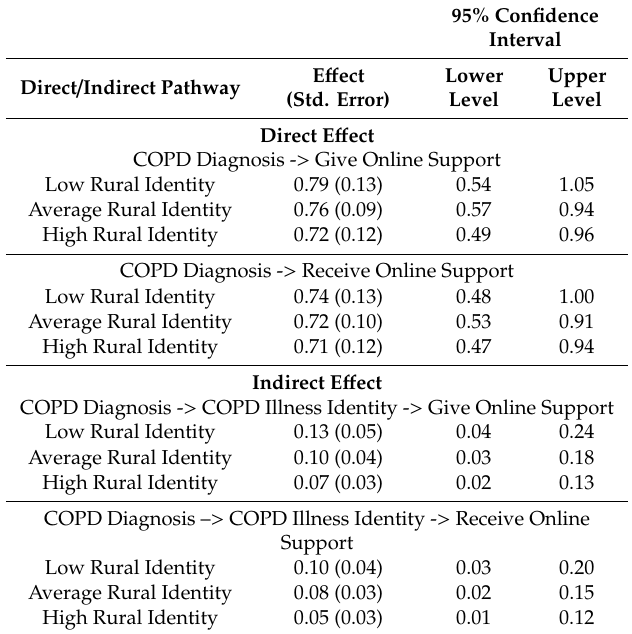
Table 4. Direct and indirect e ff ects by geographic identity ( − 1 SD , M , + 1 SD